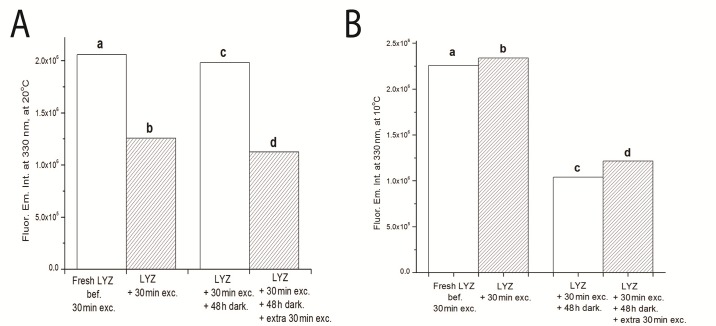

A) LYZ fluorescence emission intensity at 330nm monitored at 20°C; and B) at 10°C. Samples are described as: a) fresh LYZ never previously illuminated, b) LYZ after 30 min of continuous 295 nm illumination, c) LYZ after 30 min of continuous 295 nm illumination followed by 48 hours in the dark, d) LYZ after 30 min of continuous 295 nm illumination followed by 48 hours in the dark and subsequent further 30 min of continuous 295 nm. LYZ excitation was fixed at 295 nm with a slit size was set at 0.5 mm (1.0 μW).